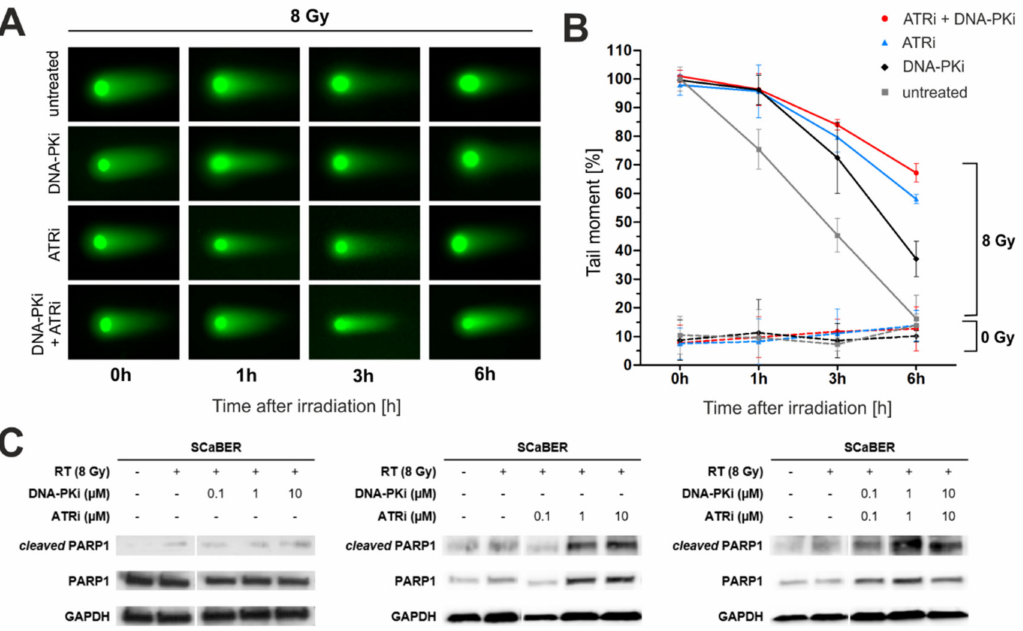
Figure 3. Blocking DNA-PK and ATR activity retards DNA repair of radiation-induced DNA damage in squamous bladder cancer cells. ( A ) Representative immunofluorescence images of stained nuclear tails are shown for each time point and treatment option (i.e., single DNA-PK and ATR inhibitor treatment (both: 10 µ M), combined treatment application of DNA-PK and ATR inhibitors, and non-treated cells (controls)). A neutral comet assay was performed and images were obtained with 20 × original magnification. ( B ) Semi-quantitative analyses of the tail moment of SCaBER cells upon combined irradiation (8 Gy) and DNA-PK/ATR DDR pathway inhibition illustrating a retarded DNA repair response. Overall n = 5493 individual cells (35–148 cells/sample) with corresponding tails were analyzed by ImageJ. The time point 0 h was used for normalization. The calculation of the tail moment of non-irradiated cells but upon DNA-PK/ATR treatment was considered as a control to exclude drug-induced DNA damage. Curves of tail moments represent means from at least n = 2 independent experiments (except for dotted control lines). ( C ) Western blots were performed to assess the cleavage of PARP1 as an apoptotic marker with and without irradiation (dose = 8 Gy) as well as upon single and dual DNA-PK/ATR inhibition in SCaBER bladder cancer cells. GAPDH was used as a loading